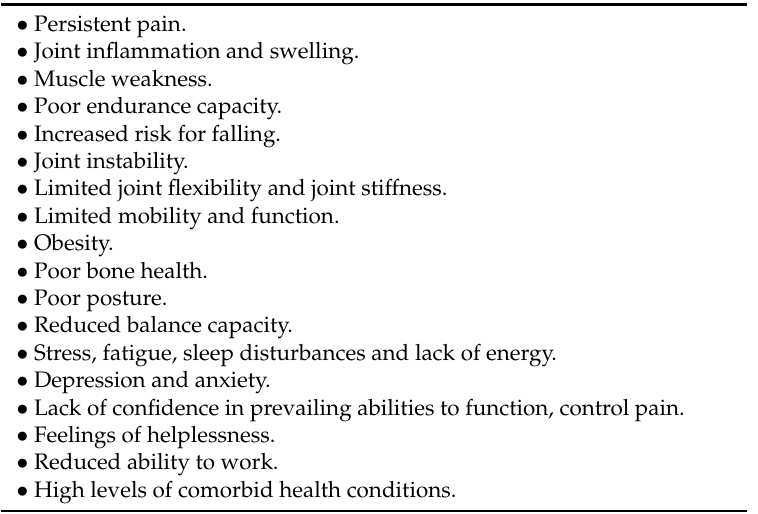
Table 1. Selected Problems Commonly Faced by People with Various forms of